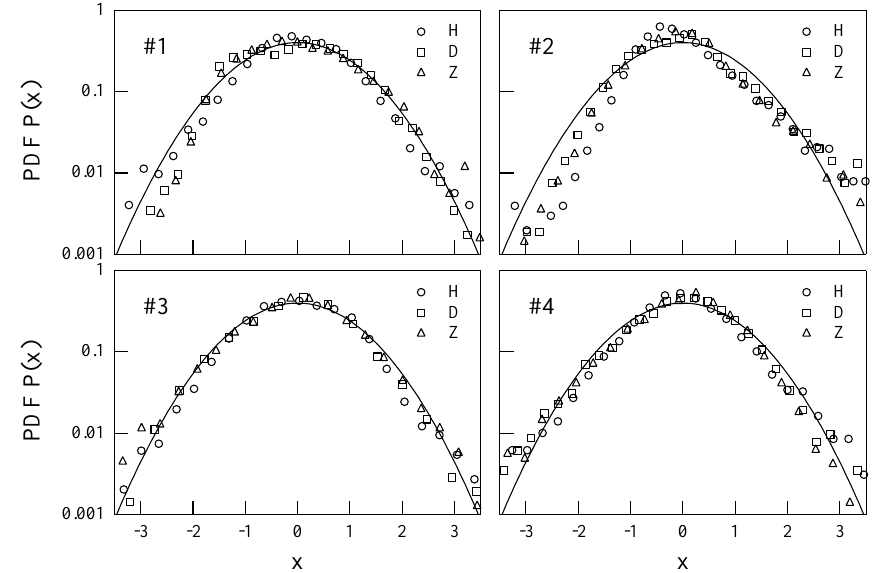
Fig. 14. The probability distribution functions of the first four PCs for the three magnetic field elements. Plot #1 and #2 refer to S q and S D daily variations as identified in the previous section. The solid line refers to a unit-variance zero-mean Gaussian